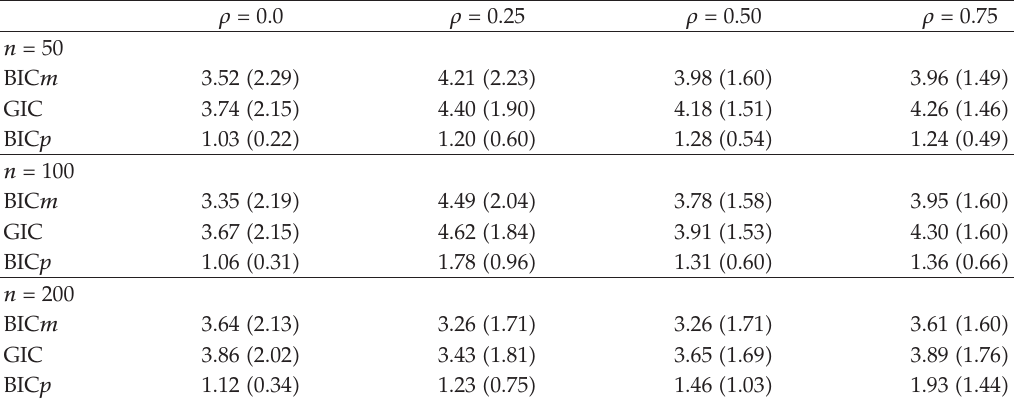
Table 7: Means (cid:3) stnadard deviations (cid:6) of the number of basis functions excluded. ρ (cid:7) 0 . 0 ρ (cid:7) 0 .